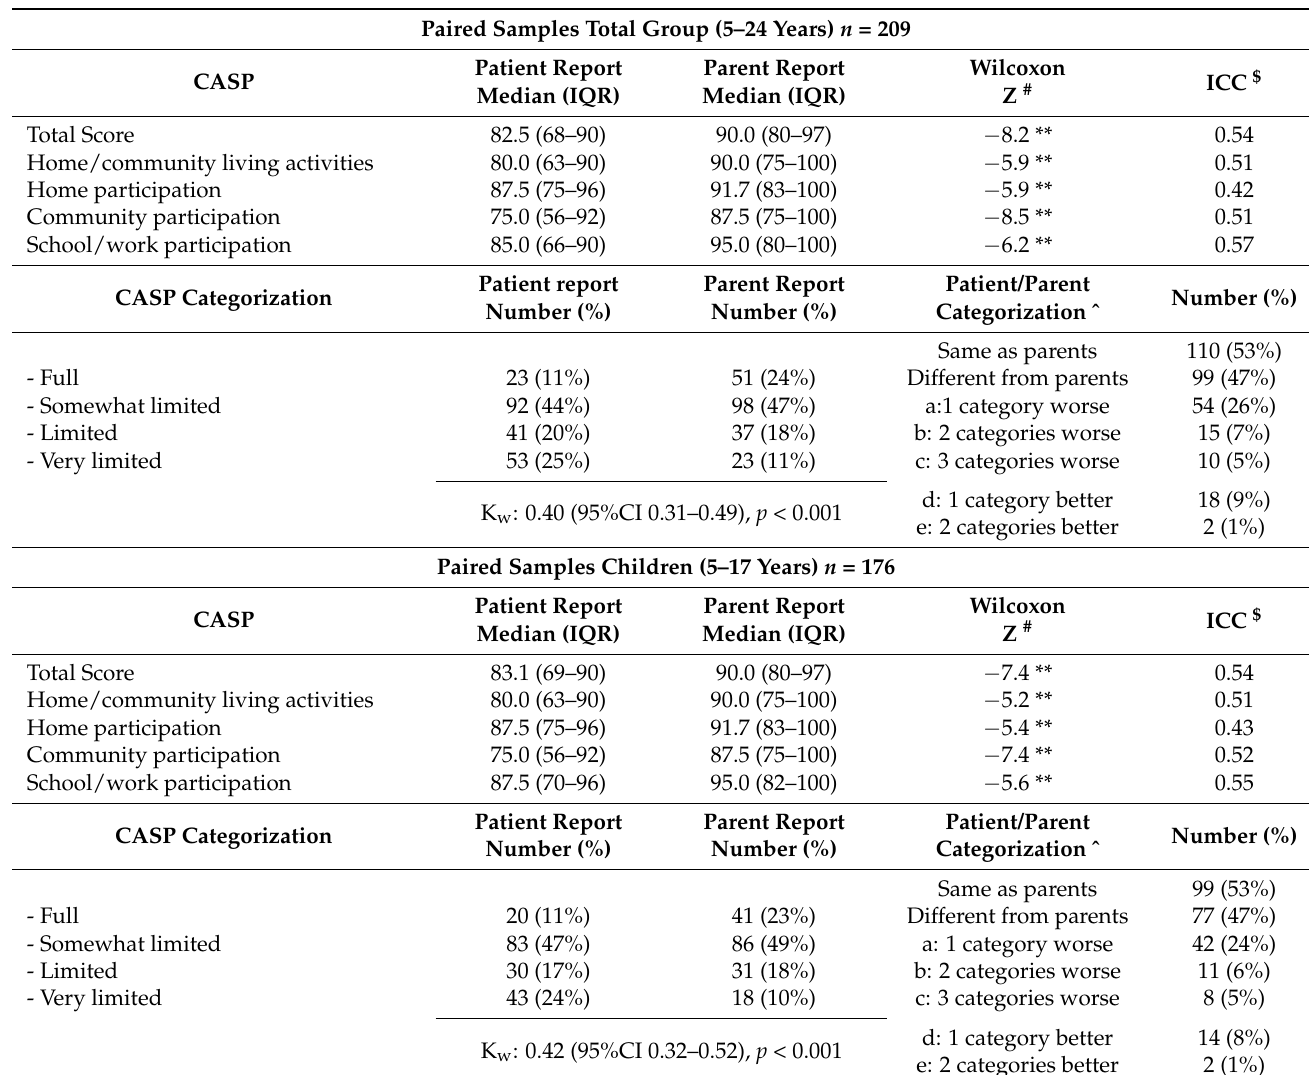
Table 4. Differences and similarities between patient and parent CASP participation scores and